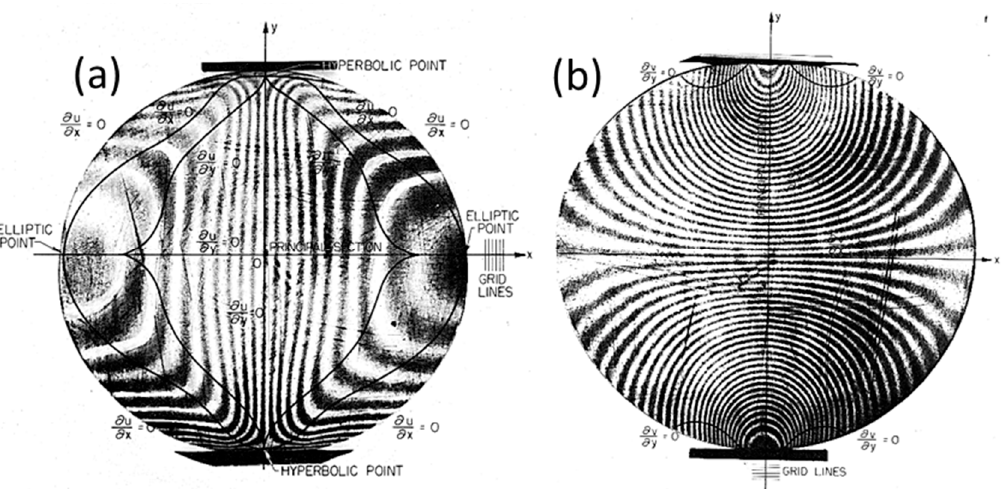
Figure 17. Moiré fringes generated for the urethane rubber disk subject to diametrical compression: ( a ) u -displacement pattern; ( b ) v -displacement pattern. Signs of displacement derivatives, lines where displacement derivatives are equal to zero, and singular points are indicated in the figure as well.